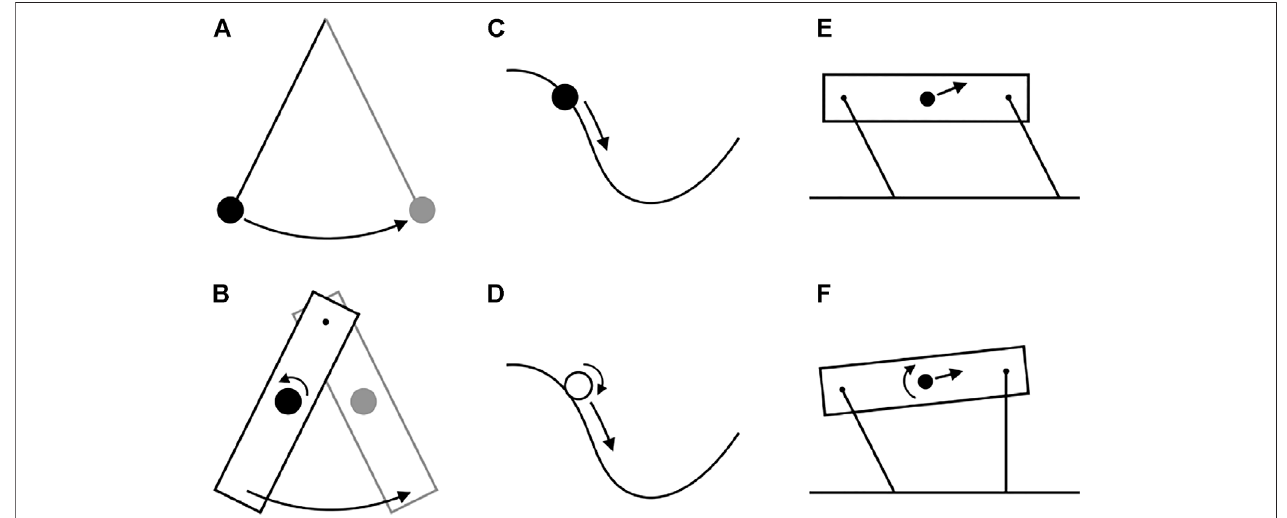
FIGURE 1 | Some examples of conservative systems with differing pendular recovery. Some systems have perfect pendular recovery (top row) while others have low pendular recovery(bottom row)becauseofenergypassivelytransferred torotational kineticenergy. (A) Theclassic point masspendulum exhibits perfect exchange betweencenterofmasskineticandgravitationalpotentialenergy (B) Aphysicalpendulum doesnot. (C) Abeadonafrictionlesswirealsohasperfect pendularrecovery, while (D) a ball rolling down a hill does not. (E) A quadruped, modelled as a 4-bar linkage with massless legs, can get perfect pendular recovery during vaulting by performing a walking trot. (F) The same quadruped gets lower pendular recovery using a four-beat